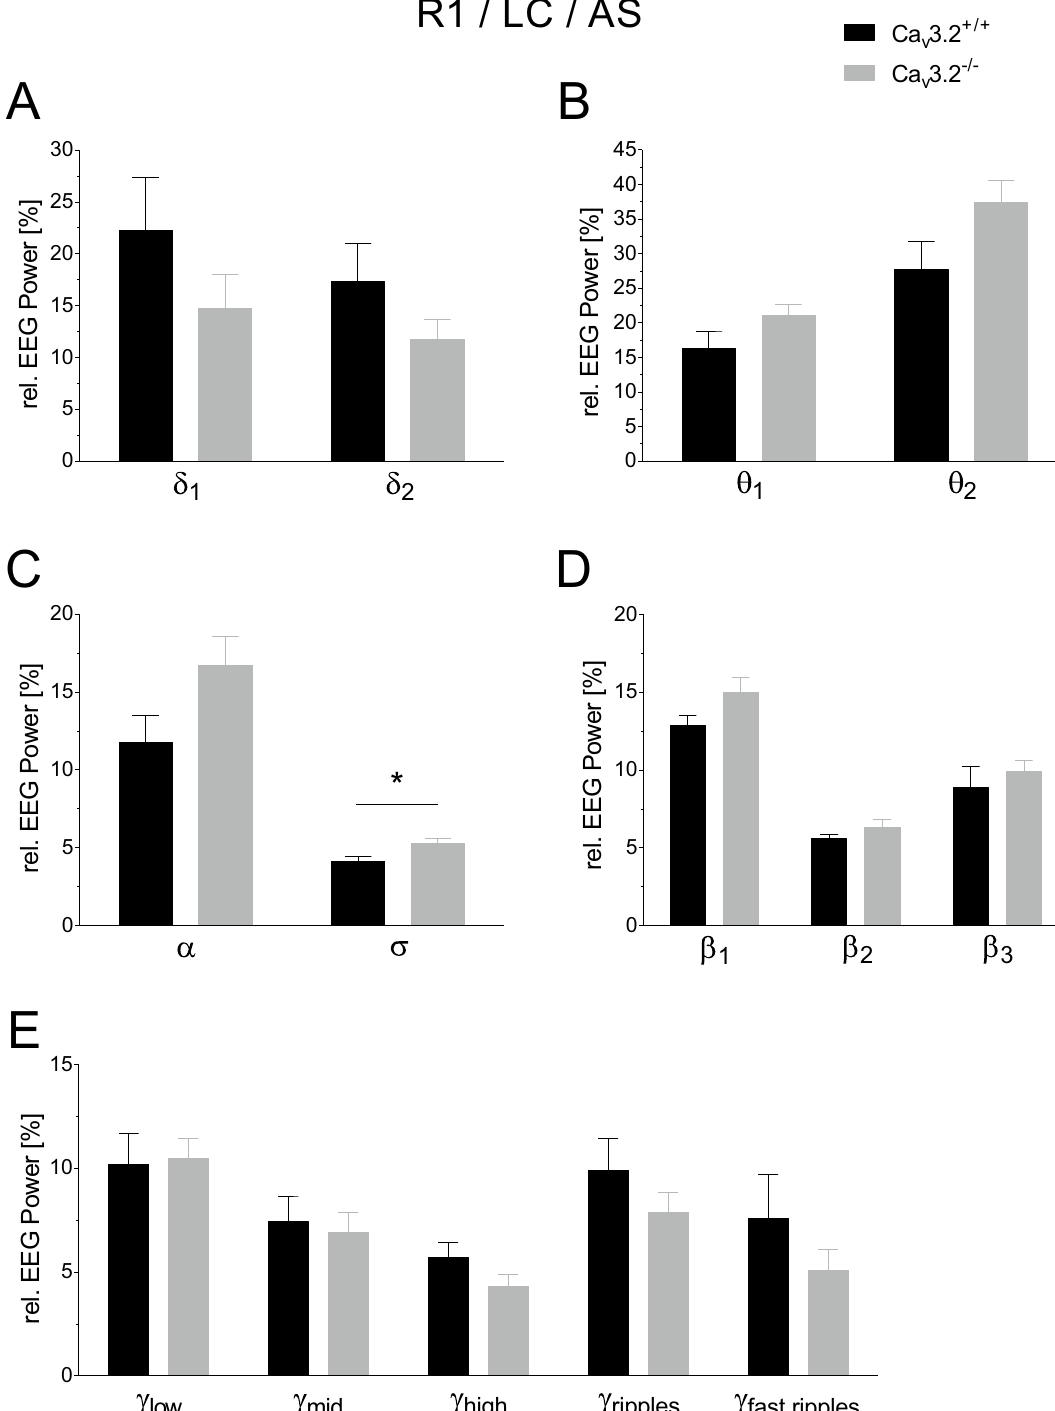
Figure 4. EEG power analysis during the active light cycle state (24 h long-term recording R1) in Ca v 3.2 +/+ and Ca v 3.2 −/− mice. Relative EEG power (%) for both genotypes is displayed for the individual frequency ranges ( A–E ). A significant change was observed for